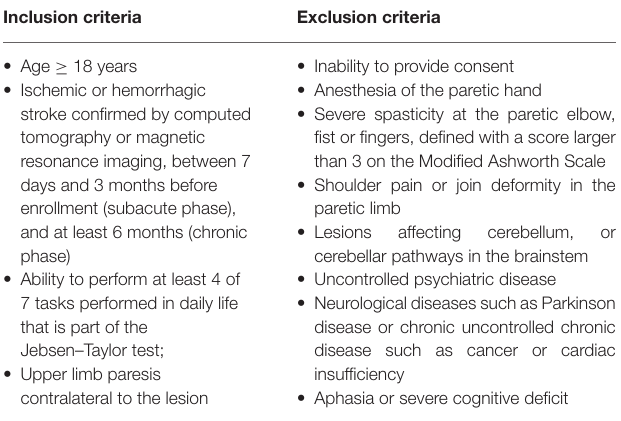
TABLE 1 | Inclusion and exclusion